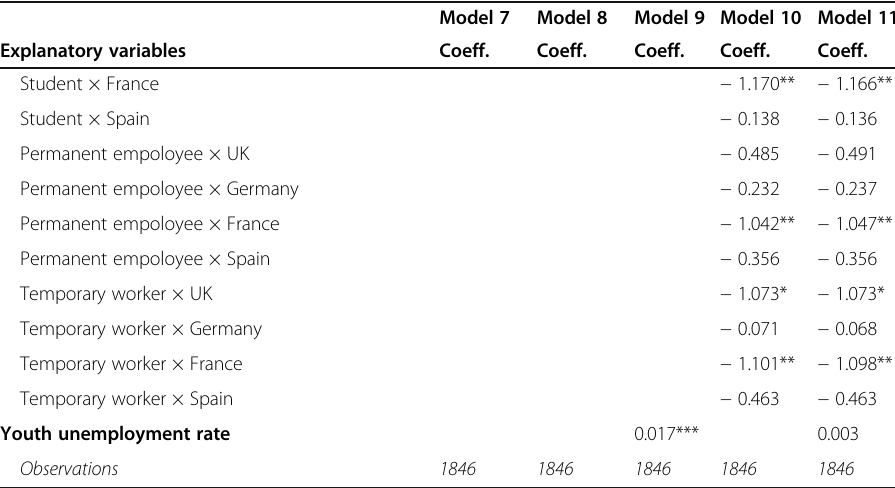
Table 6 Results of ordered logistic regression for the determinants of the decision of postponing or abandoning the plan of going to live on their own. (Continued)